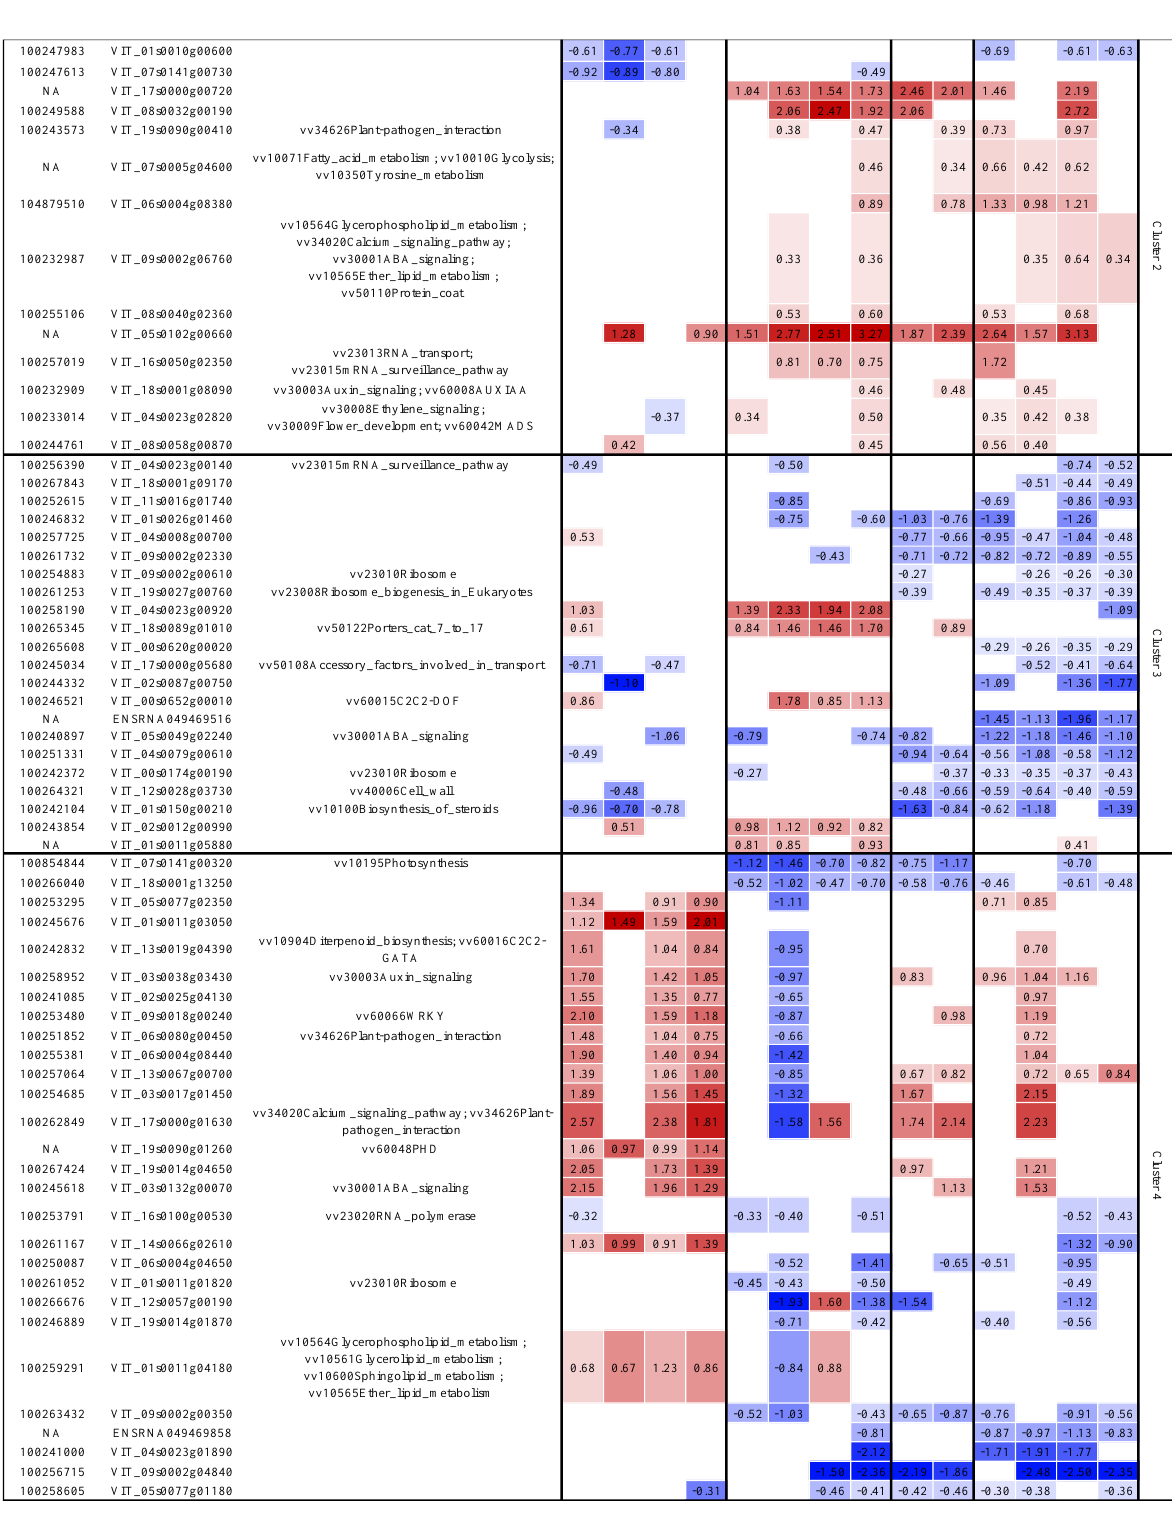
Figure 5. Log fold change of conserved genes affected by GRBV infection based on results from the Venn Diagram in Figure 4. Transcripts are grouped together in clusters based on dendrogram output. Negative values (blue) indicates a decrease in gene expression in diseased grapes and positive values (red) indicate an increase in gene expression in diseased grapes compared to healthy grapes. Color gradient indicates the size of log fold change. 110R = Cabernet Sauvignon on rootstock 110R and 420A = Cabernet Sauvignon on rootstock 420A.